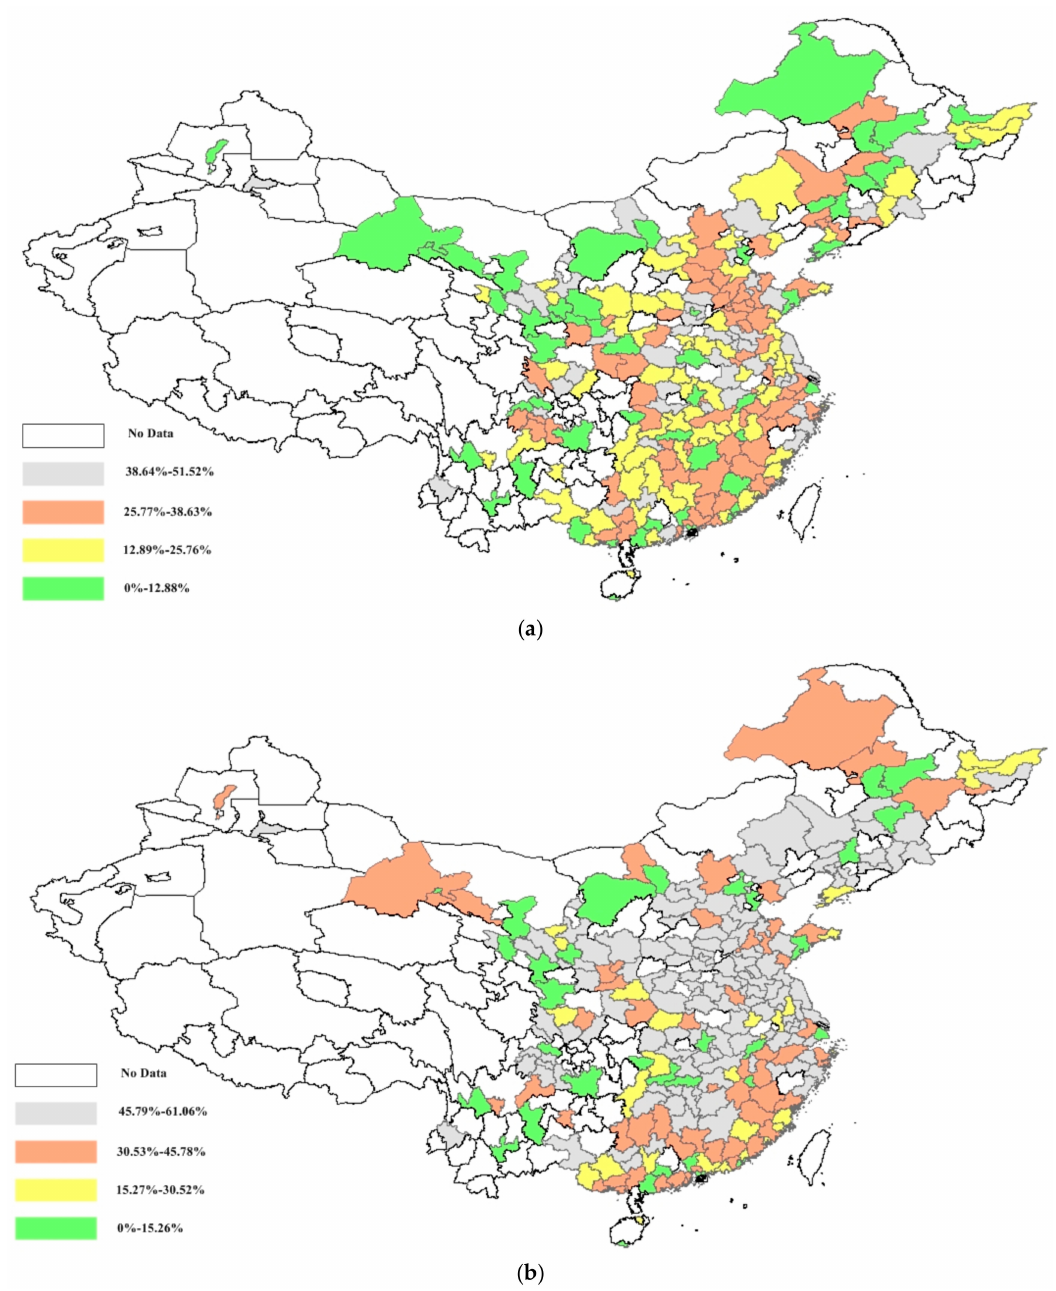
Figure 8. Potential mortality reductions from overall ( a ) and environmental ( b )